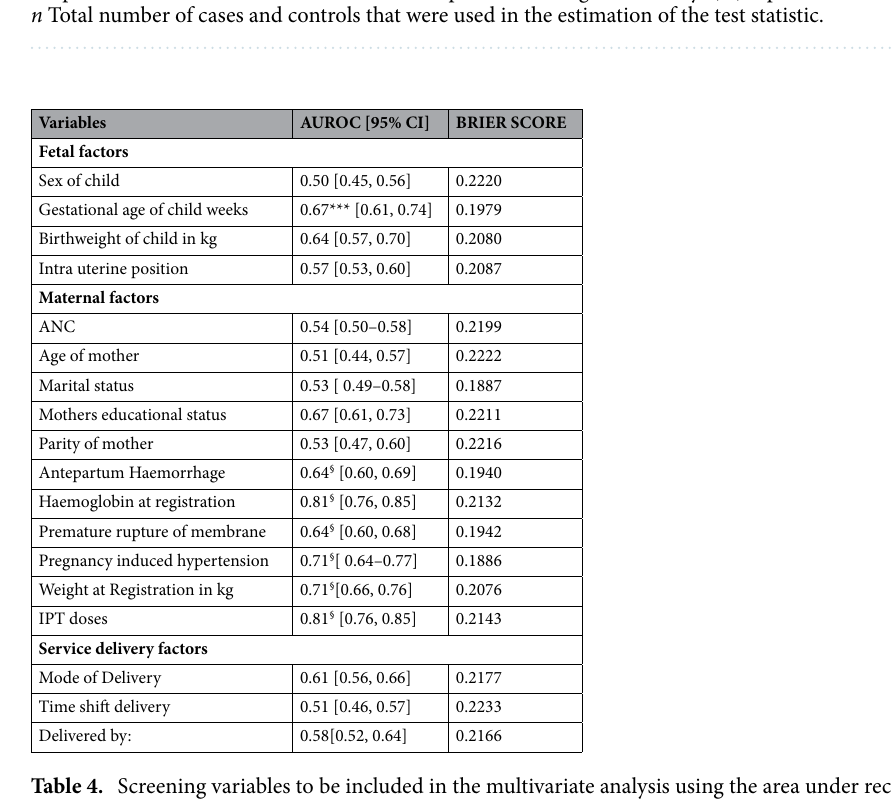
Table 4. Screening variables to be included in the multivariate analysis using the area under receiver operating characteristics curve and the Brier score. AUROC Area under receiver operating curve. CI confidence interval. § indicates variables included in the multivariable analysis, IPT Intermittent Preventive